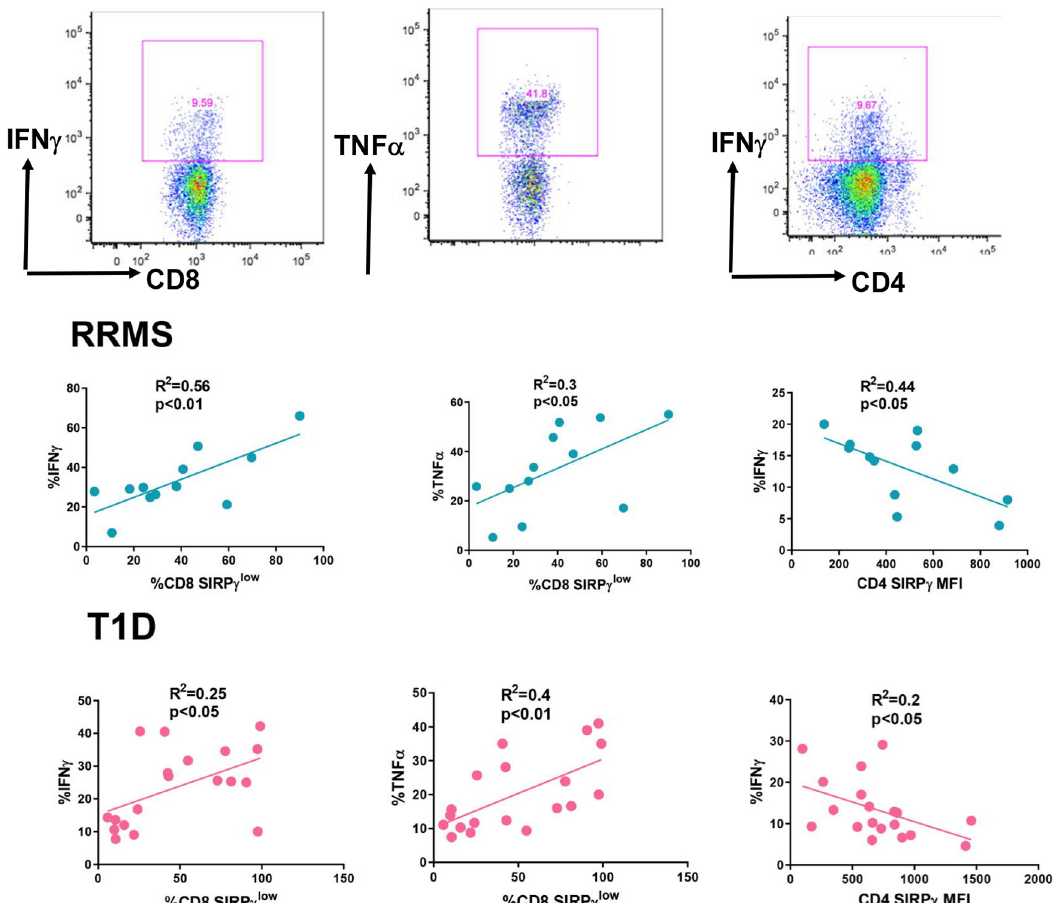
Fig 4. SIRP γ low T-cells positively correlate with proinflammatory molecules in subjects with autoimmunity. PBMCs from RRMS and T1D patients were activated with PMA/INO in the presence of golgi plug for 6 hrs. Representative flow plots for IFN γ and TNF α staining on T-cells are shown. Following stimulation, cells were stained extracellularly with fluorescently tagged anti- CD3, CD4, CD8, and SIRP γ , followed by intracellular staining with anti-IFN γ , and anti-TNF α . Data was correlated with Pearson’s test and p < 0.05 was considered